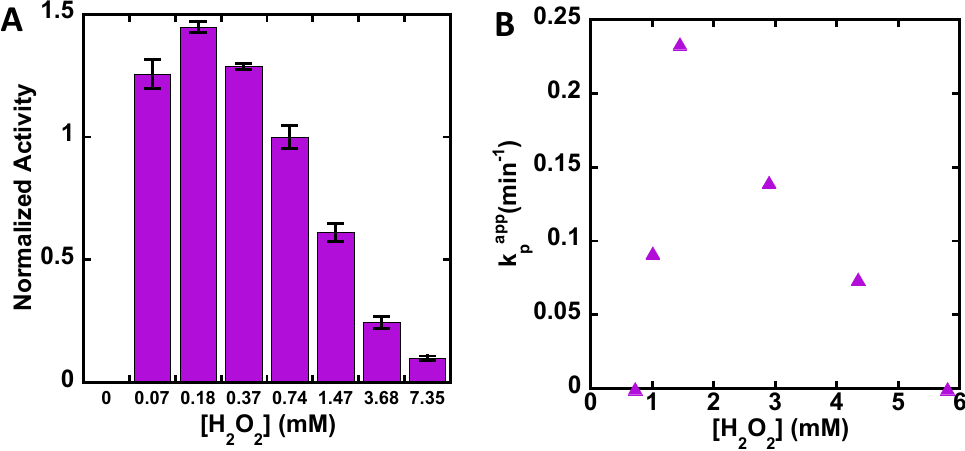
Figure 7. ( A ) Relative rate of enzymatic activity, as a function of H 2 O 2 loading, measured by the reaction of aminoantipyrine and phenol, normalized to activity at [H 2 O 2 ] = 0.74 mM loading; ( B ) Apparent polymerization rate (k papp ) under the conditions: [DMAm] 0 :[PAETC] 0 :[ACAC] 0 :[H 2 O 2 ] 0 = 100:1:9.7: X , [DMAm] = 170 mM, [HRP] = 0.71 mg/mL in 4.2 mL of pH = 5.5, 20 mM acetate buffer at 25 °C.